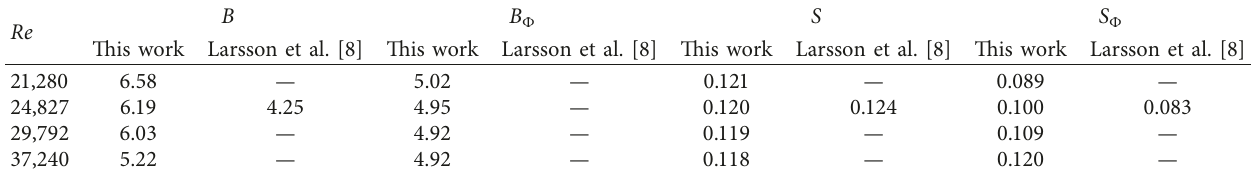
Figure 7: The calculated spreading of the mean: (a) streamwise velocity; (b) scalar concentration. Table 2: The calculated centerline decay and radial spreading